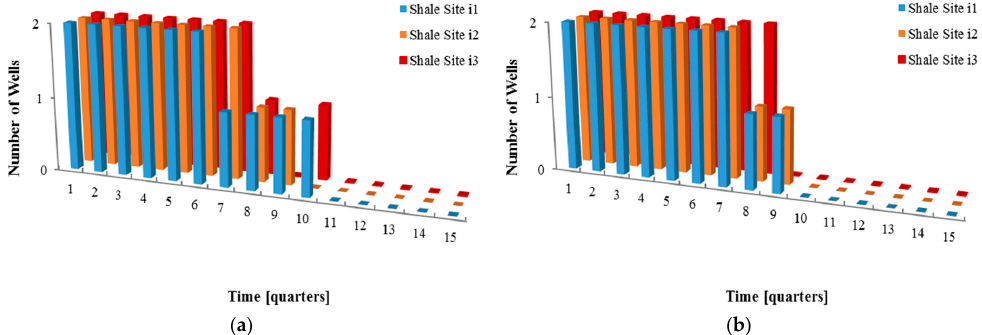
Figure 6. ( a ) Optimal drilling and fracturing plan for deterministic case; ( b ) Optimal drilling and fracturing plan for stochastic case.